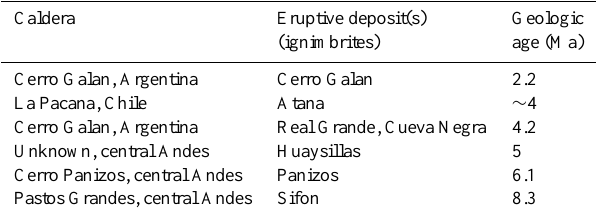
Table 1. Quaternary Andean “super eruptions” from Table 2. Largest explosive eruptions in the Andean region during caldera/ignimbrite systems in the Altiplano-Puna plateau of the 19th–21st centuries, with assigned Volcanic Explosivity Index the central Andes. A “super eruption” is defined by Mason et (VEI) equal to or greater than 4 (see text for discussion). Data al. (2004) as one erupting ≥ 10 15 kg of ejecta; Ma=millions of years sources: Simkin and Siebert (1994); GVPc (2009). ago. (Data source: Mason et al., 2004, Table 2). Eruptive deposit(s)